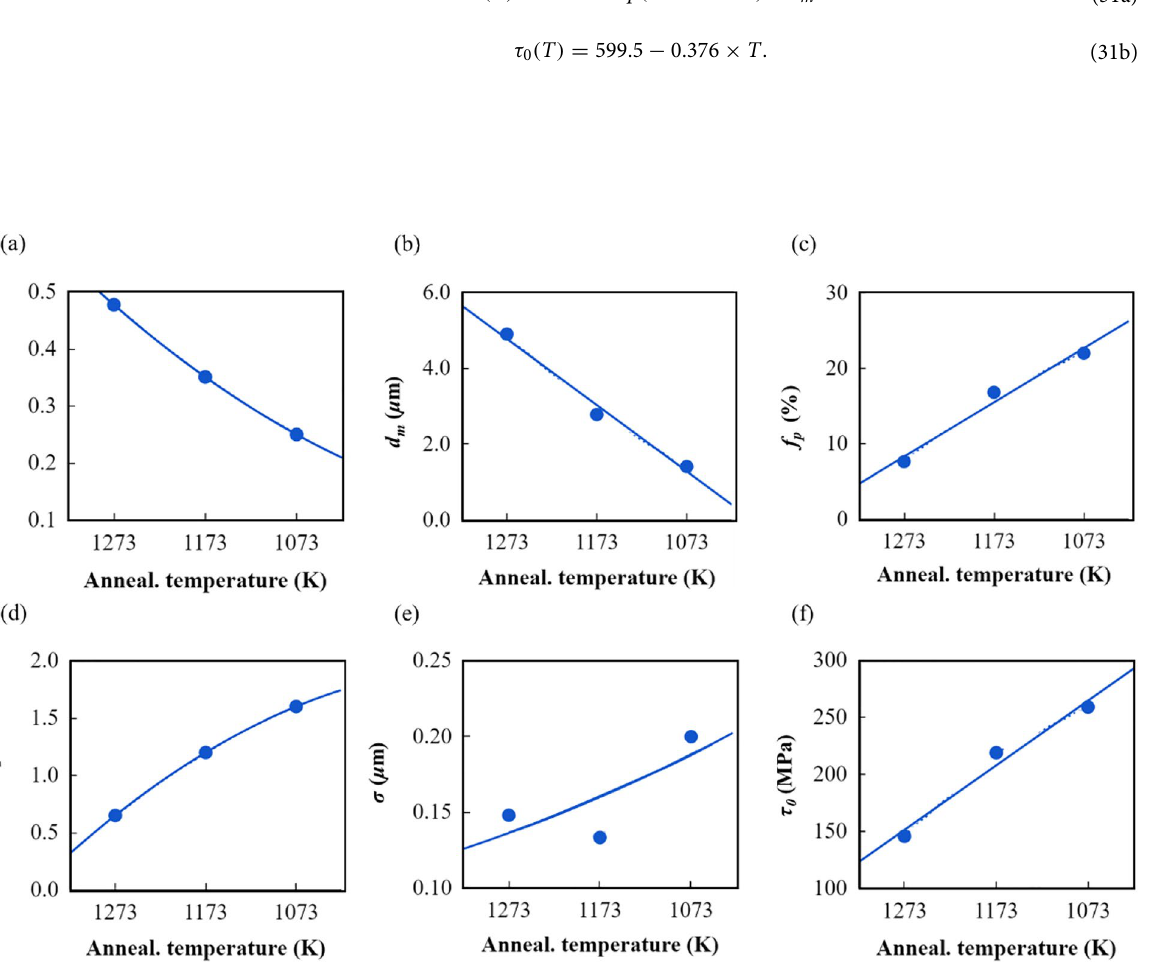
Figure 5. The relationships between the model parameters and annealing temperature: ( a ) mean radius of the precipitate; ( b ) mean size of the train; ( c ) volume fraction of the precipitates; ( d ) dynamic recovery parameter of dislocations stored statistically; ( e ) standard deviation of the precipitates with a normal distribution; and ( f ) initial shear strength of the